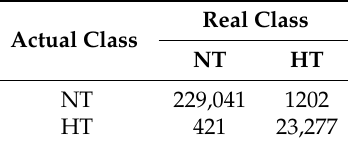
Table 8. The confusion matrix for Naive Bayes over Risk Stratification between normotension (NT) and Hypertension at both stages